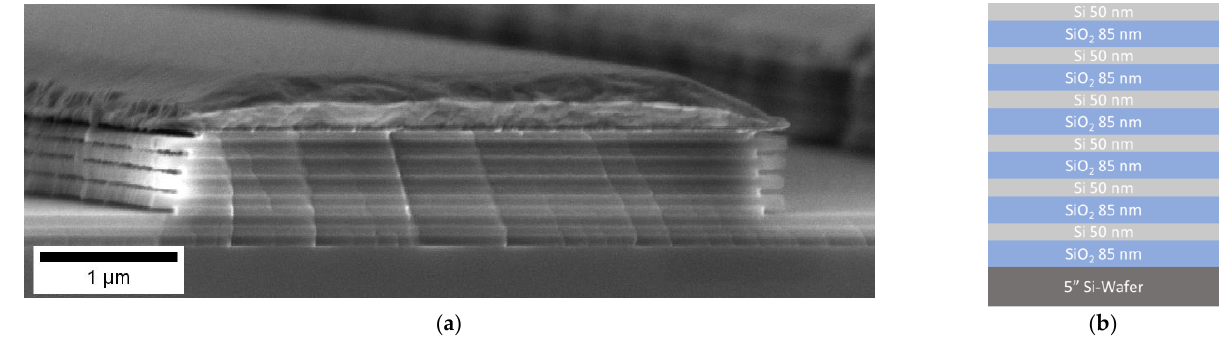
Figure 4. ( a ) A multilevel underetched structure with a gold mask defined by optical lithography. The lithographic structure is 5 µm wide. SEM image on the cross-section of the layer stack after the dual-stage etching (first etch step stopped after Si layer #5). ( b ) Schematic sequence of layers (without the gold hard mask).